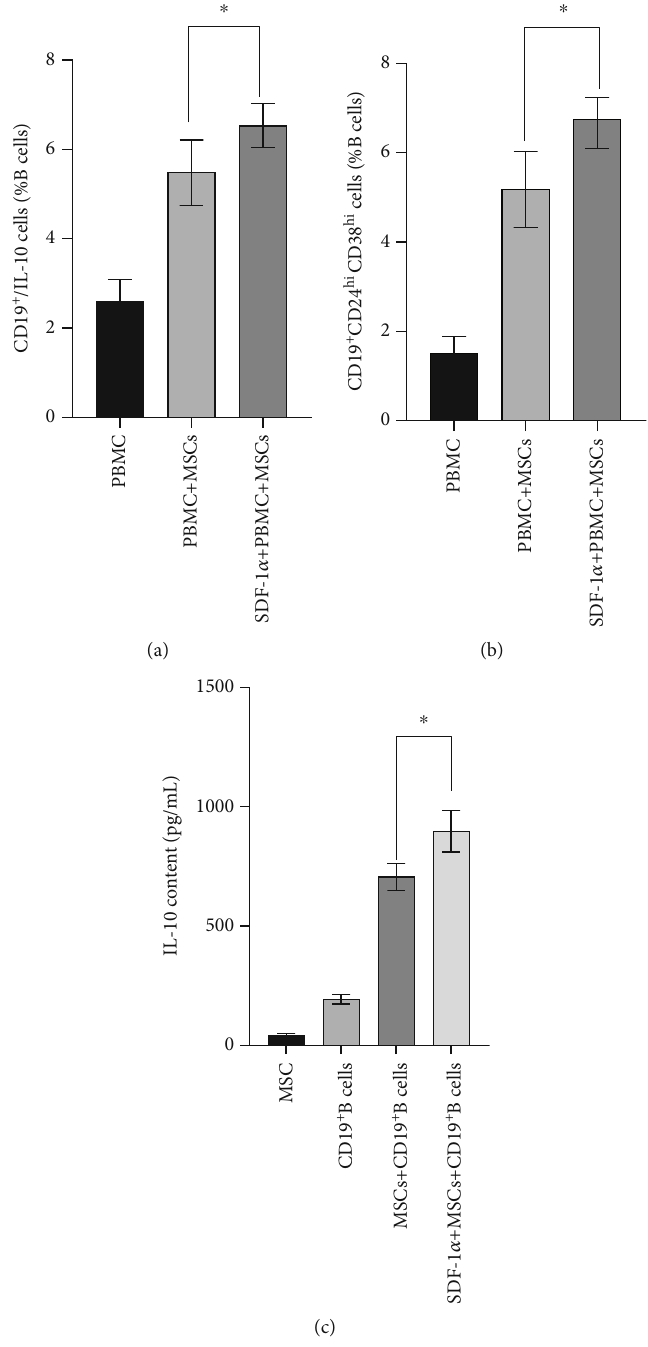
Figure 3: SDF-1 α pretreatment enhances the property of MSCs in promoting the Breg di ff erentiation. (a, b) 0.1 μ g/mL SDF-1 α promotes the e ff ects of MSCs on IL-10-producing CD19 + B cells or CD19 + CD24 hi CD38 hi cell di ff erentiation. (c) After being treated with 0.1 μ g/mL SDF-1 α , MSCs can increase the secretion of IL-10 from B cells further ( 897 ± 87 pg/mL vs. 706 ± 55pg/mL ). ∗ P < 0 : 05